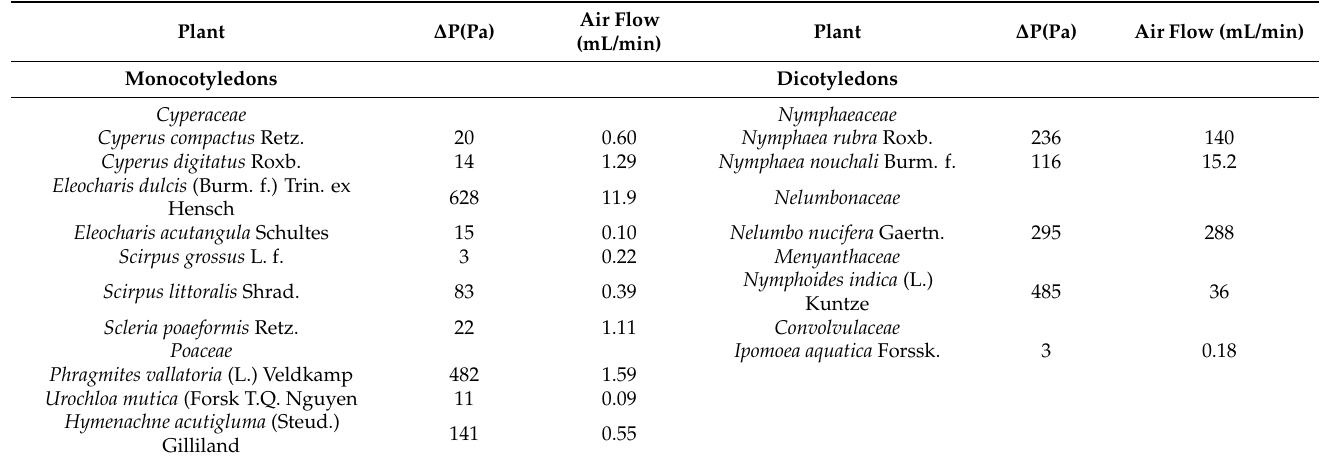
Table 1. Comparison of pressure differences and convective gas flow in twenty species of tropical angiosperms (adapted from Konnerup et al.